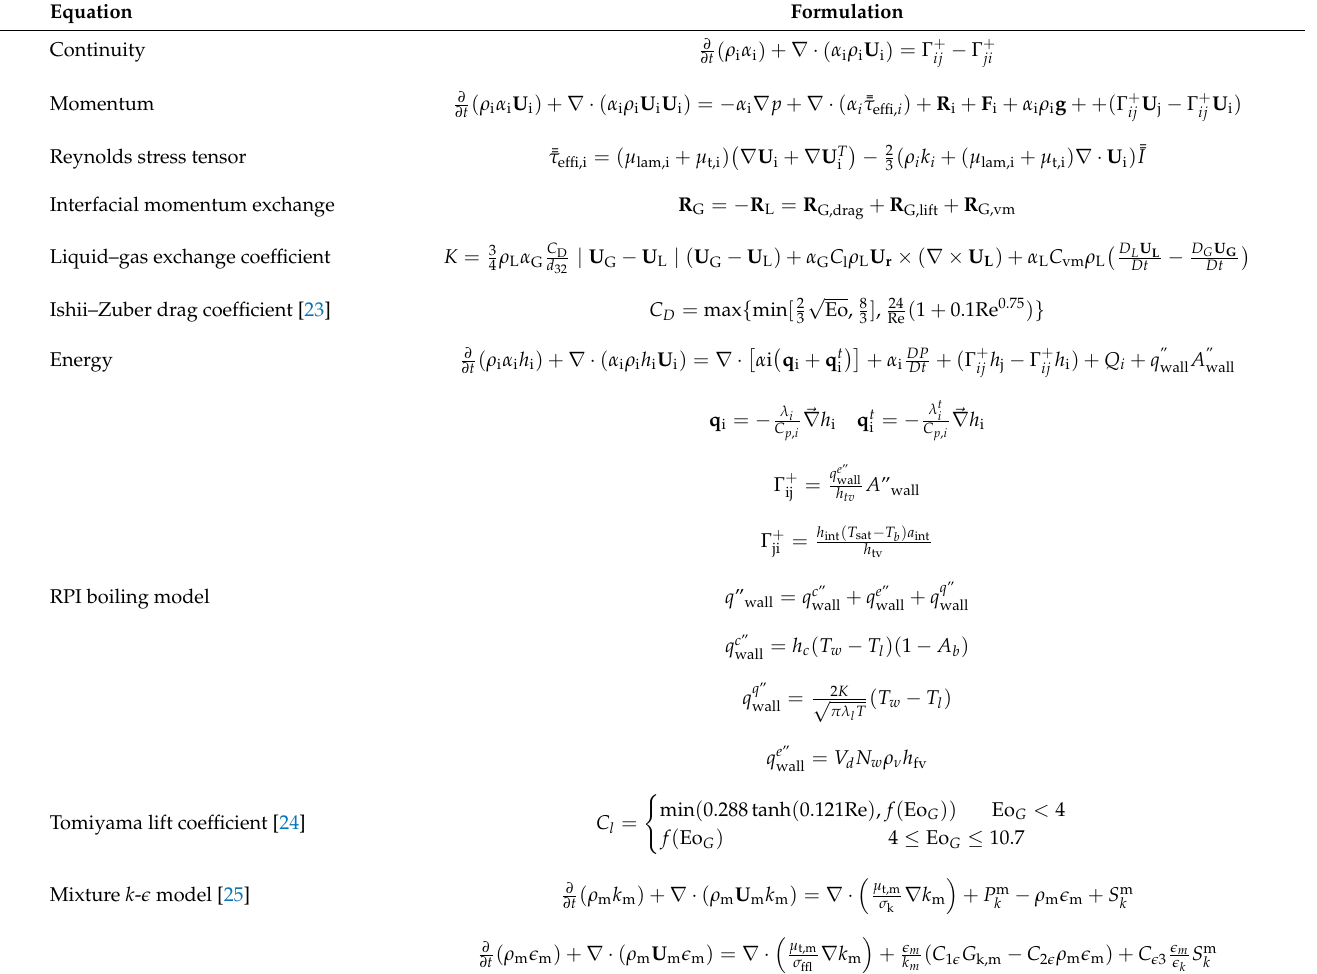
Table 7. Governing equations of Waterside [22].